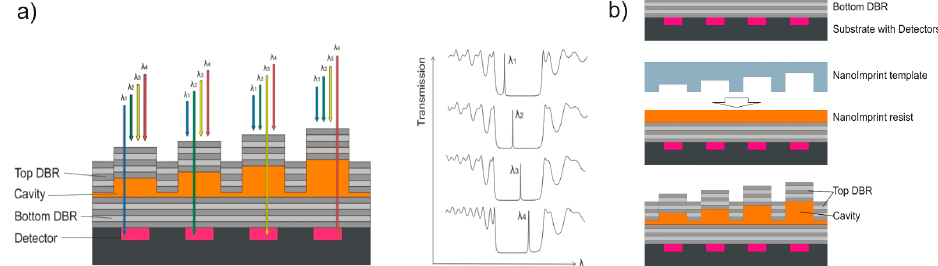
Figure 1. ( a ) Schematic design of a Fabry–Pérot filter-array-based nanospectrometer (left) and its corresponding calculated transmission spectra (right). ( b ) Fabrication process involving substrate conformal imprint lithography (SCIL).